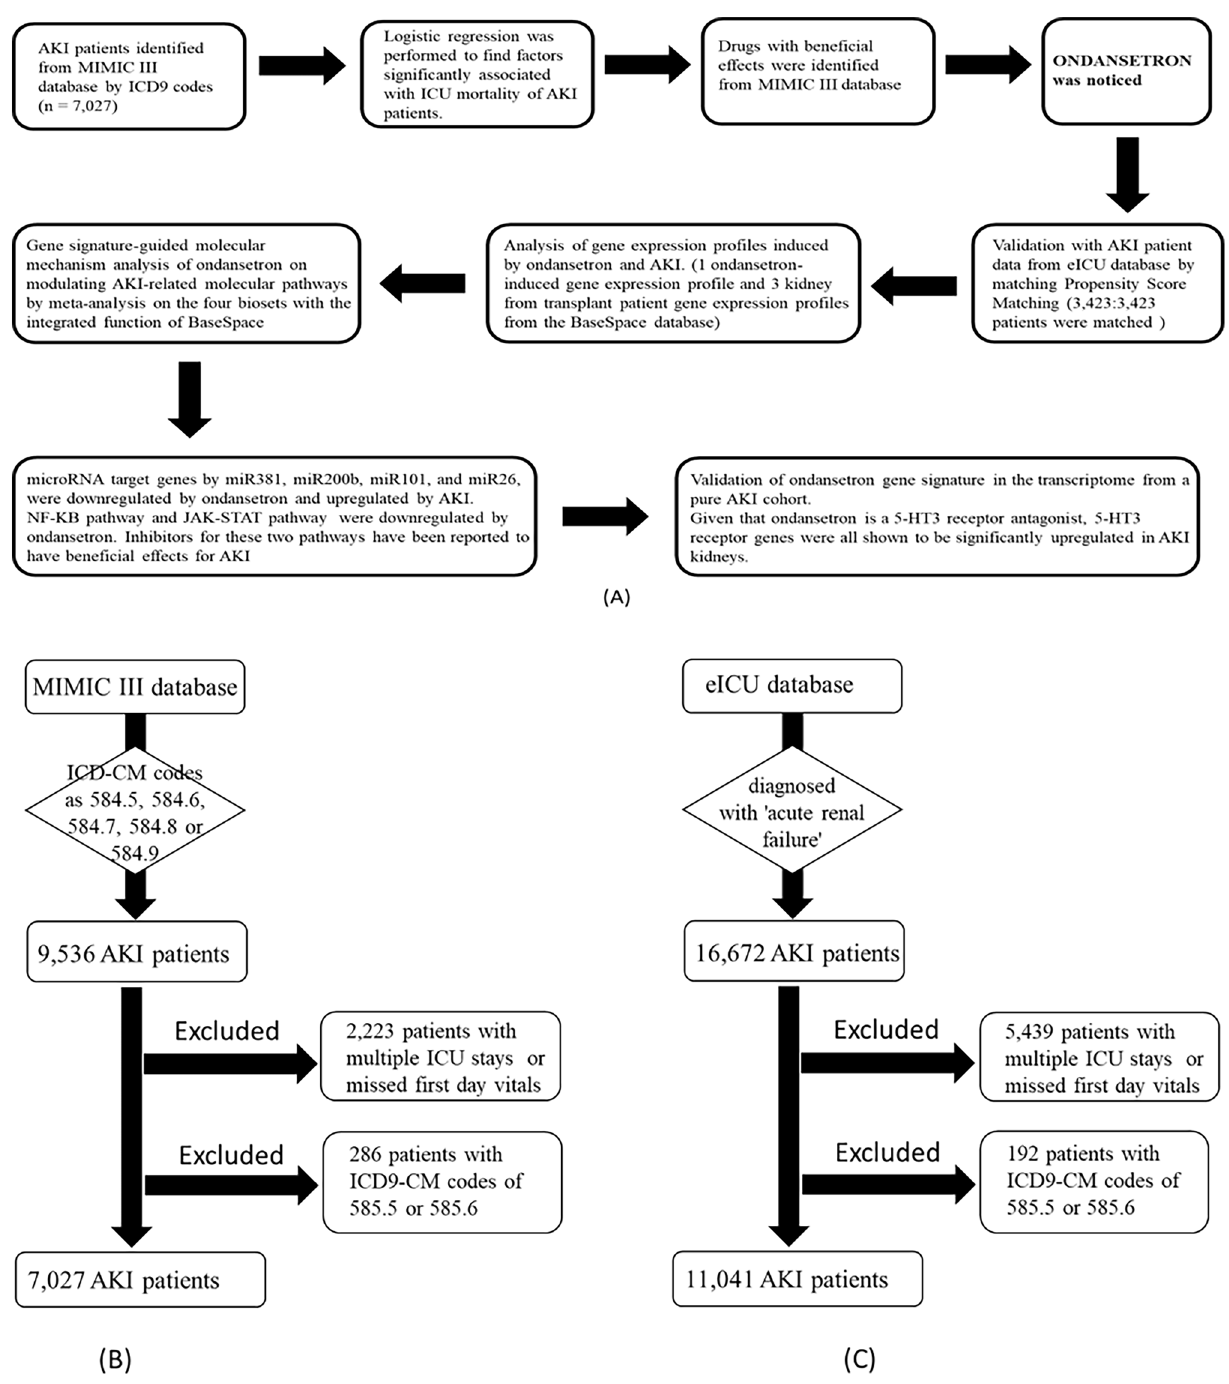
Figure 4. The flowcharts of procedures ( A ) The overview of the experimental design. ( B ) The flowchart of AKI patient inclusion in MIMIC III database. And ( C ) the flowchart of AKI patient inclusion in eICU database. AKI: acute kidney